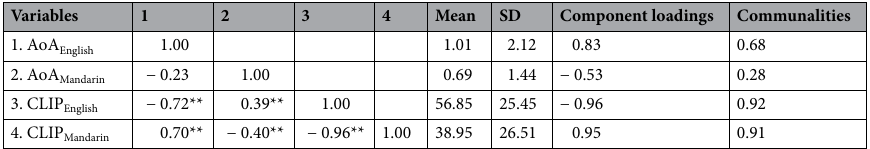
Table 2. Descriptive statistics, Pearson correlation matrix, component loadings and communalities from a Principal Component Analysis for independent variables. One component (the bilingual balance factor) was extracted with an initial eigenvalue of 2.79. ** indicates correlation is significant at the alpha level of 0.01 (2-tailed).